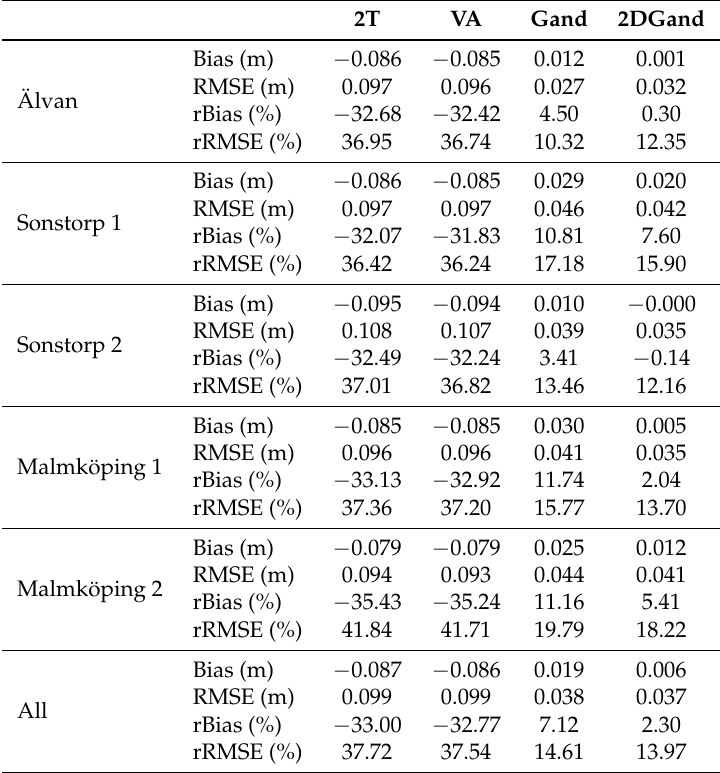
Table 3. Bias, RMSE, relative bias and relative RMSE (rRMSE) of the various estimators on the different sites. Ganders’ direct method on centered and 2D projected points (2DGand) performed best. The median value of Ganders’ direct method (Gand) also performed well.